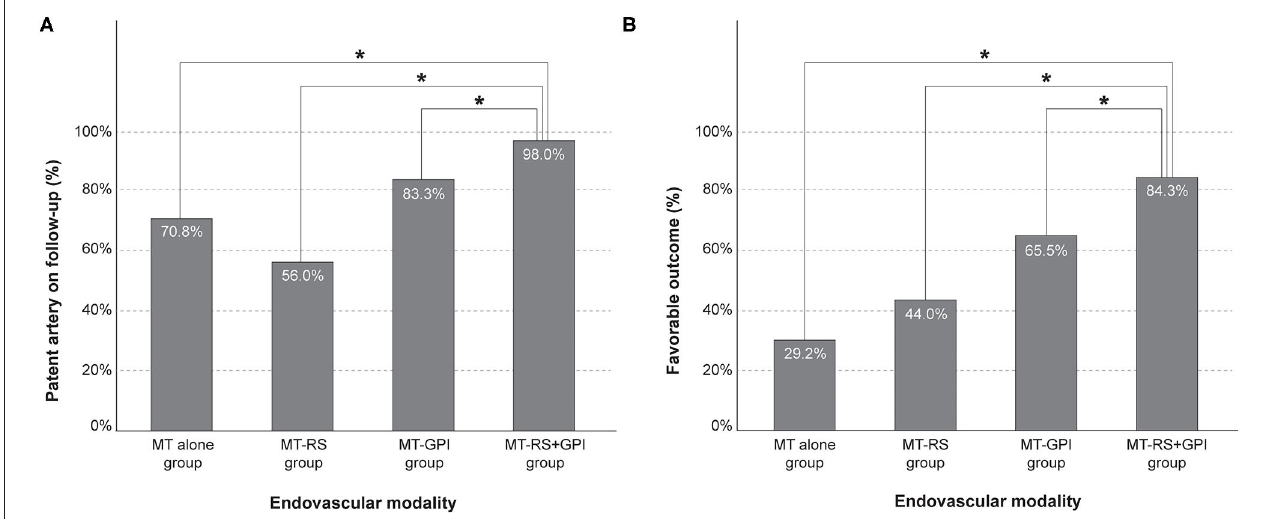
FIGURE 2 | Frequency of (A) patent artery on follow-up and (B) favorable outcome based on endovascular modality. MT-RS, rescue stenting after mechanical thrombectomy failure; MT-GPI, glycoprotein IIb/IIIa infusion after mechanical thrombectomy failure; MT-RS + GPI, rescue stenting with glycoprotein IIb/IIIa infusion after mechanical thrombectomy failure. *Significantly different between